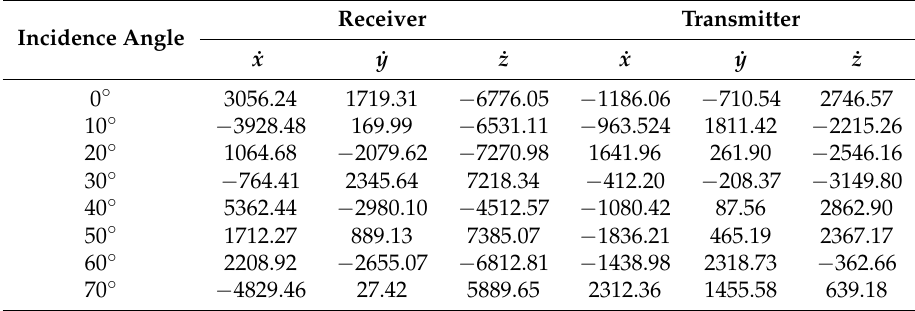
Table A2. Receiver and transmitter satellite velocities (m/s) in the Earth-centered Earth-fixed (ECEF)